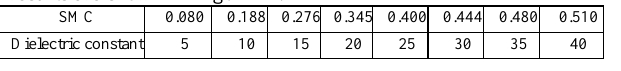
Table 2 . The experiment results for the Topp model.